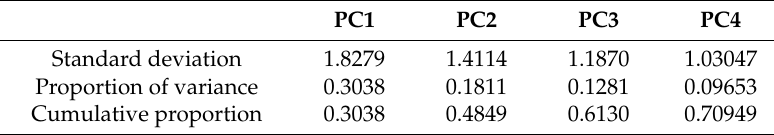
Table 7. Explanation of variance in statistical